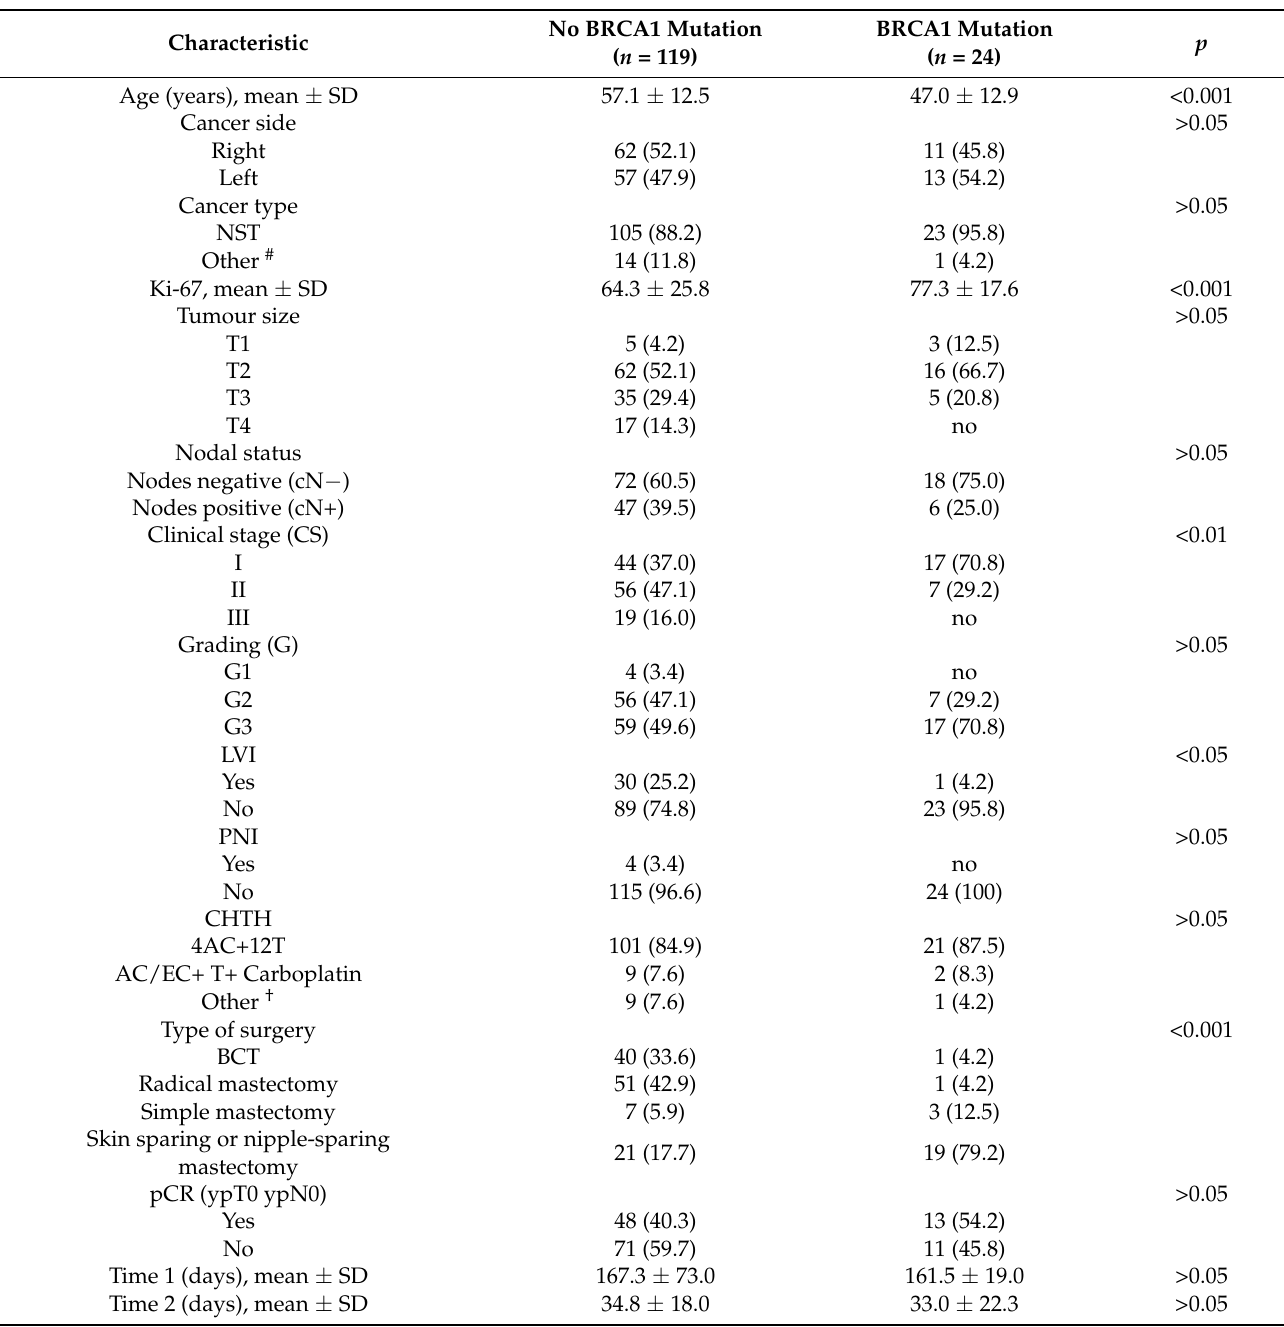
Table 2. Basic characteristic of study group by BRCA1